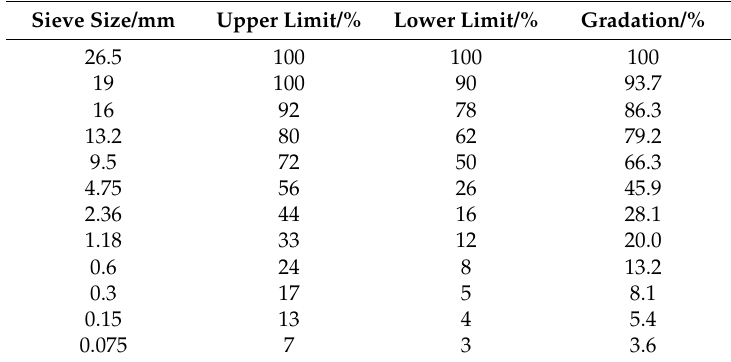
Table 6. The properties of asphalt mixtures.